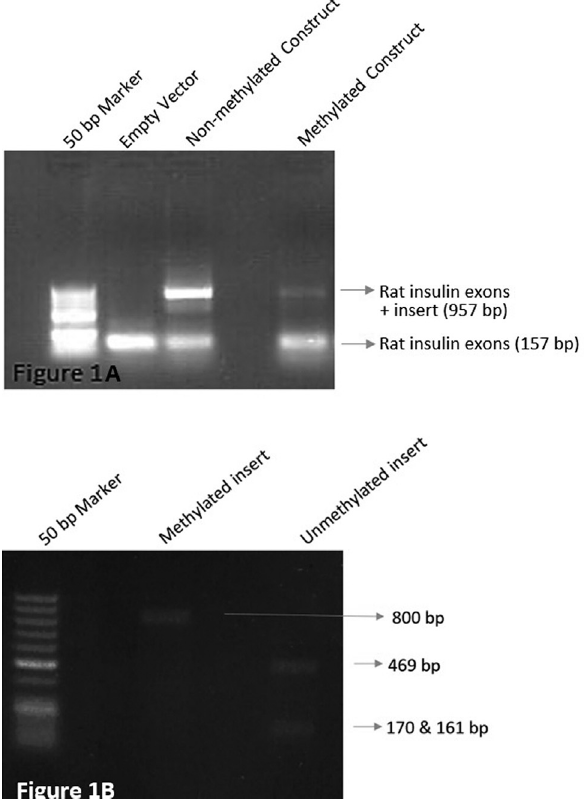
Figure 1 - Agarose gel results of the splicing reporter experiments A) Agarose gel of PCR performed with primers specific to rat insulin exons. Methylation of the MEFV second exon leads to its splicing, which can be observed as a broader band at 157 bp, similar to the empty vector ampli- fied with rat insulin exon primers. B) Agarose gel of the restriction en- zyme analysis for confirmation of the methylation. The methylated con- structisnotcut,whereasnon-methylatedconstructiscutby Sma Ienzyme, which is sensitive to